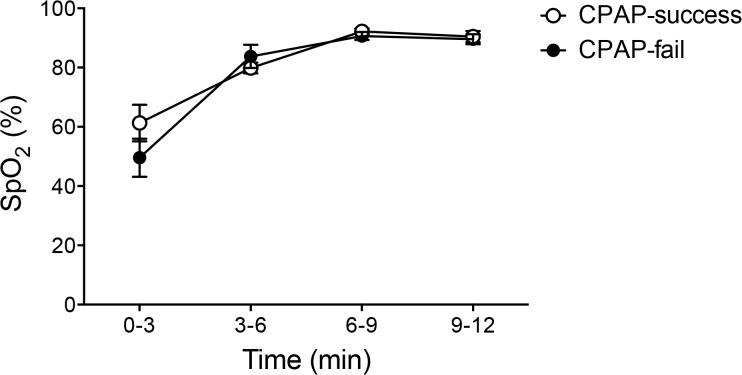
Oxygen saturation changes in the first 12 minutes after birth in preterm newborns.Open circles are CPAP success newborns. Closed circles are CPAP fail newborns.